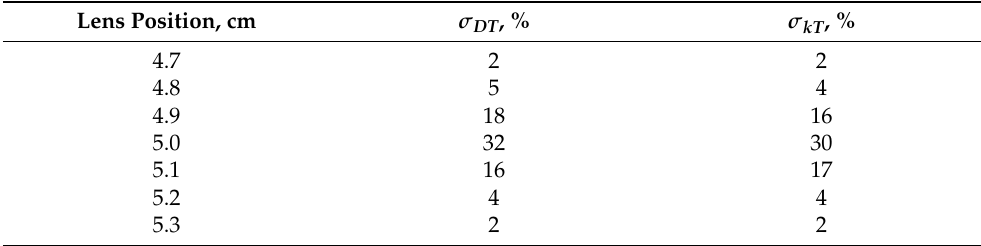
Table 3. Values of PuB radii for different positions of forming lens and ratio of PuB/PrB radii. Lens Position,